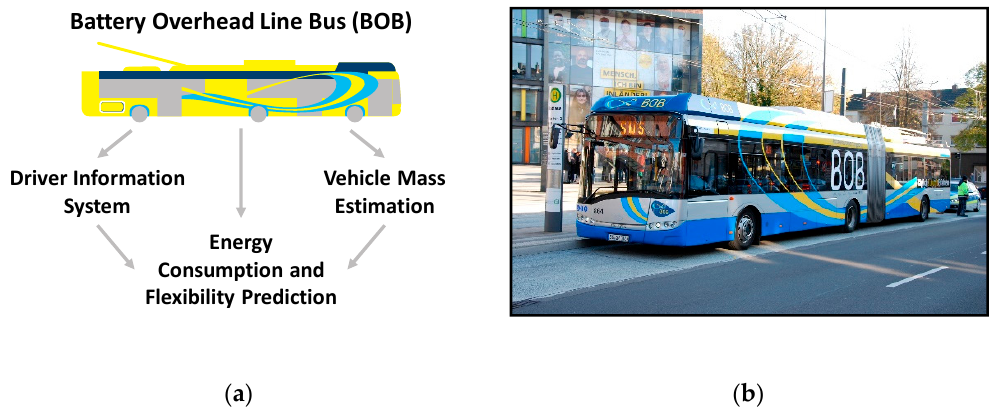
Figure 2. ( a ) Vehicle based Research Focuses. ( b ) The first battery-overhead-bus (BOB) of Solingen.